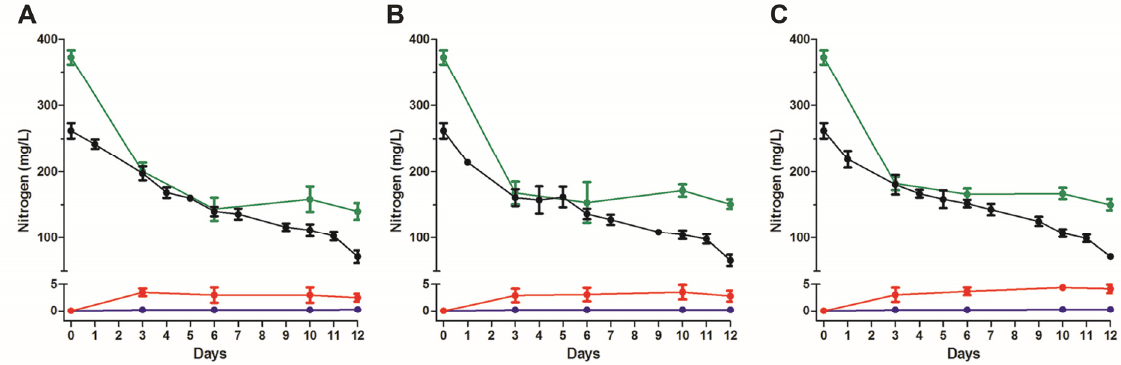
Figure 7. Change of nitrogen compounds’ concentration of isolated bacteria. Bacterial strains were inoculated in LMM (A 600 nm = 0.1) and the levels of total nitrogen ( • ), ammonia ( • ), nitrite ( • ) and nitrate ( • ) monitored during the cell growth at 28 ◦ C. Cultures were: Klebsiella sp. ( A ), Castellaniella sp. ( B ) and Acinetobacter sp. ( C ). Total nitrogen is the sum of ammonia, nitrites, nitrates and organic nitrogen compounds from leachate and cellular macromolecules. The optical density (A 600 nm ) of cultures was 0.3–0.4 at the 12th